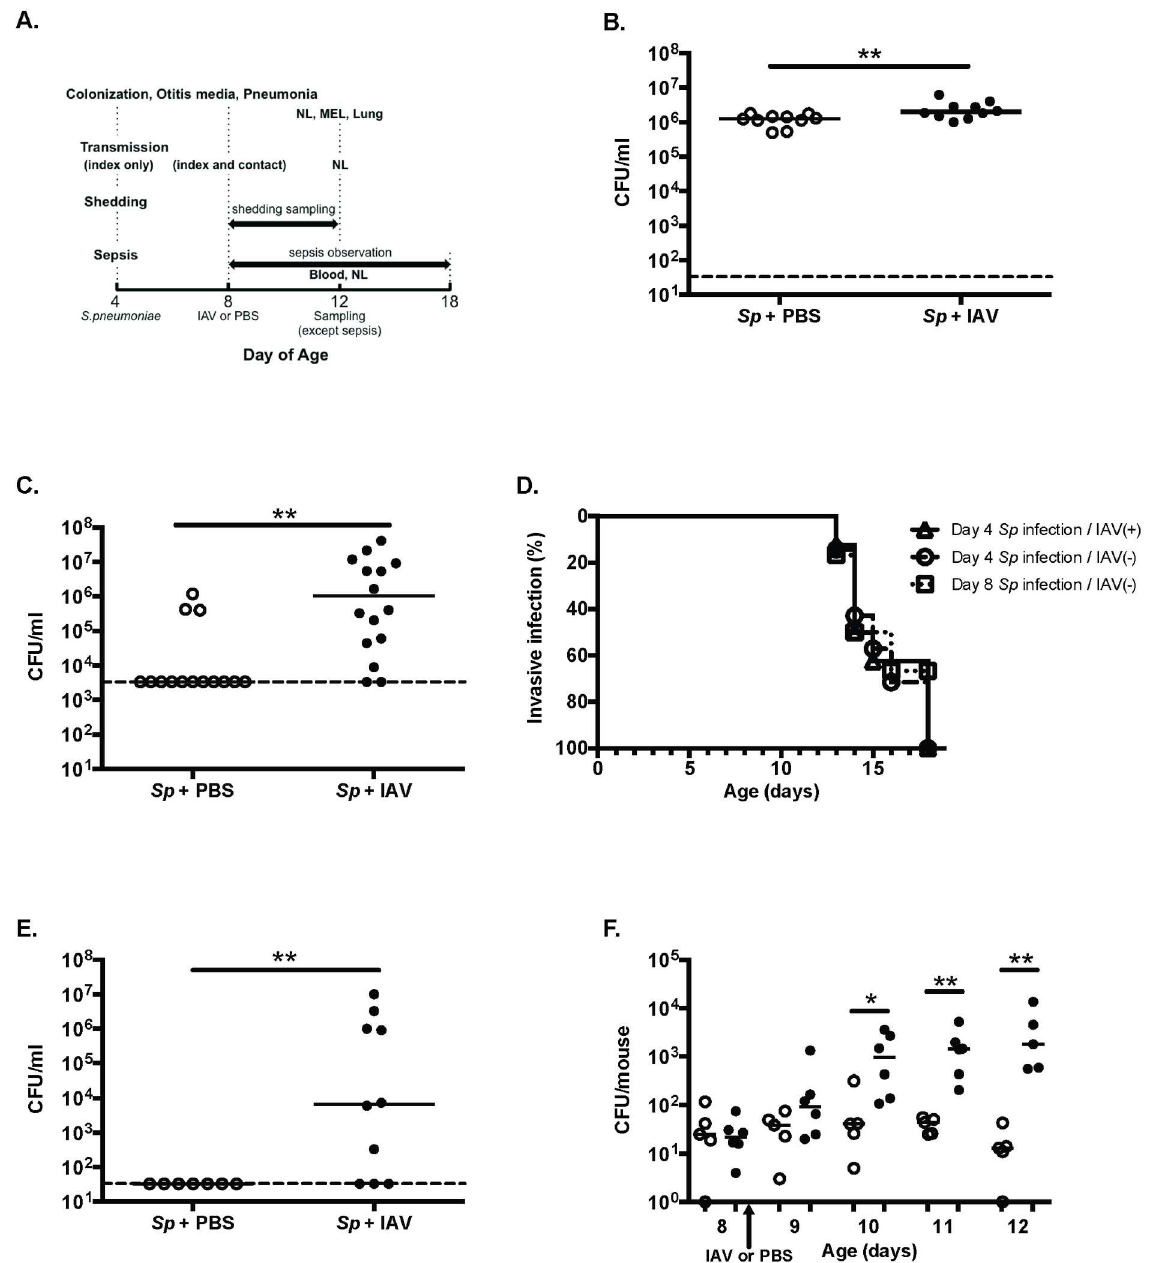
Fig 1. Infant mouse model for co-infection of S . pneumoniae and influenza virus. A. Schematic of the experimental schedule. On day 4 of age, pups were intranasallyinoculatedwith a serotype 6A clinical isolate of S . pneumoniae . At age 8 days, the pups were inoculatedwith influenzaA virus (IAV strain x31) or PBS. On day 12 of age, the pups were sacrificed and samples listed (NL, nasal lavage. MEL, middle ear lavage. Lung, lung homogenate) were collected. The followingchanges to the schematic described above were made. For the transmission experiments, one pup (index) was infected with S . pneumoniae and returned to the littermates (contacts). For the sepsis experiments, pups were not sacrificed at day of age 12 and monitored until showingsign of sepsis or euthanizedat day of age 18 to obtain blood cultures. For the sheddingexperiments,daily cultures of secretions were obtained from day of age 8–12. B, C, E, F. Comparisons between the S . pneumoniae ( Sp ) and IAV co-infection group (black circle) and the S . pneumoniae plus PBS control infection group (open circle) and in each infection model. Each dot represents a single mouse. Mann-Whitney U test was used for the statistical analyses. * p < 0.05 and ** p < 0.01 respectively. The dashed line indicates the detection limit. B. Colonizationassessed by the density of pneumococci in nasal lavages. C. Otitis media assessed by the density of pneumococci in middle ear lavages. D. Time course of septic or sustained bacteremic infection. Pups were colonized with S . pneumoniae at age 4 days with (solid line, triangle, n = 8) or without IAV (dashed line, circle, n = 7) or at age 8 days without